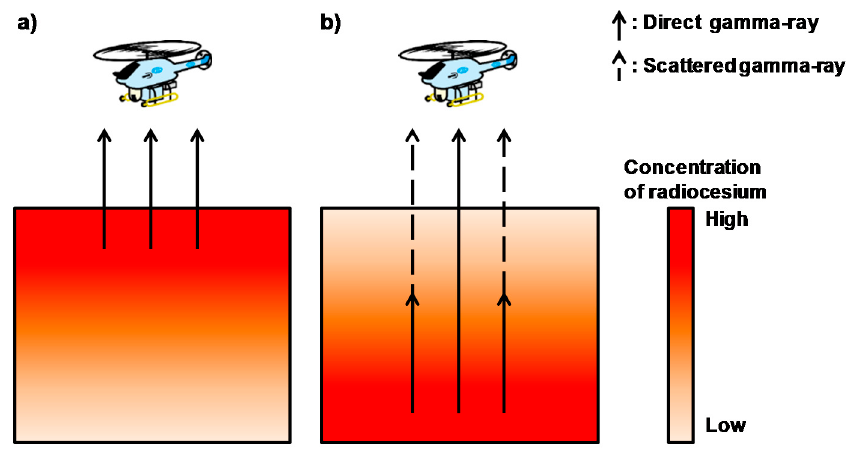
Figure 3. Image of gamma-rays derived from radiocesium in the soil; ( a ) normal condition and ( b ) irregular condition following inversion tillage.